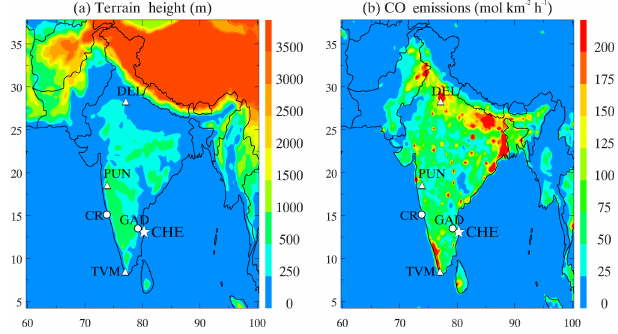
Figure 1. (a) The simulation domain of WRF-Chem covering the South Asian region at a spatial resolution of 30 × 30km, includ- ing topography map. (b) Anthropogenic emissions of CO over the South Asian region for June 2008 from the HTAP v2.2 emission inventory. The location of Chennai (CHE) is shown over which the profiles have been measured as a part of the CARIBIC pro- gram. Cape Rama (CR) and Gadanki (GAD) are two additional sites for which ground-based measurements have been used. The three ozonesonde stations Delhi (DEL), Pune (PUN) and Thiruvanantha- puram (TVM) are also